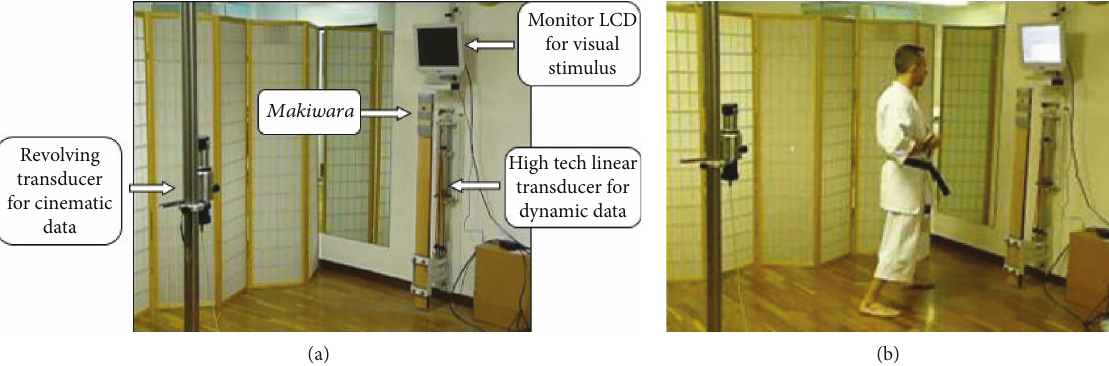
Figure 2: The “ Ergo-Mak ” integrated system used to record kinematic, dynamic, and psychoergonomic movement parameters of the athletic feat. Details of measurements are in the text (see Supplementary materials and video